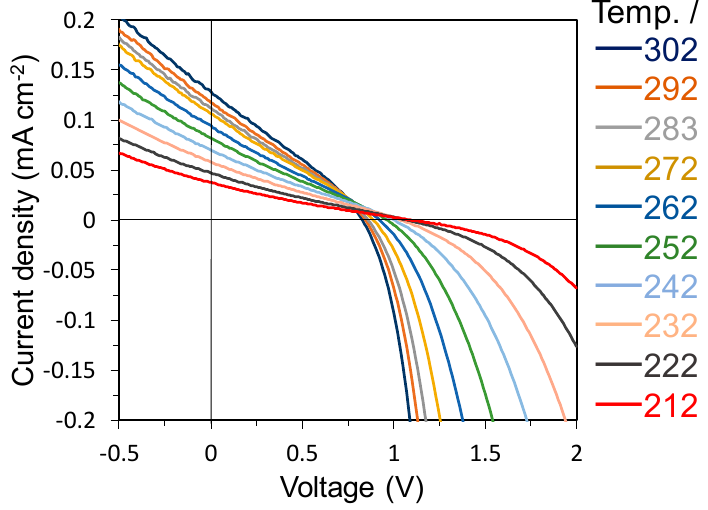
Figure 1. J–V curves for the 5% doped pn- homojunction device at various temperatures under AM 1.5 irradiation (100 mW cm − 2 ).